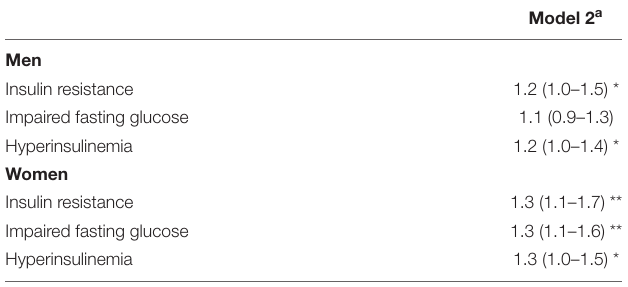
TABLE 7 | Weighted odds ratios (95% confidence intervals) for insulin resistance, impaired fasting glucose, and hyperinsulinemia of participants with the increase of per standard deviation uric acid (Men = 2,498, women = 2,650).